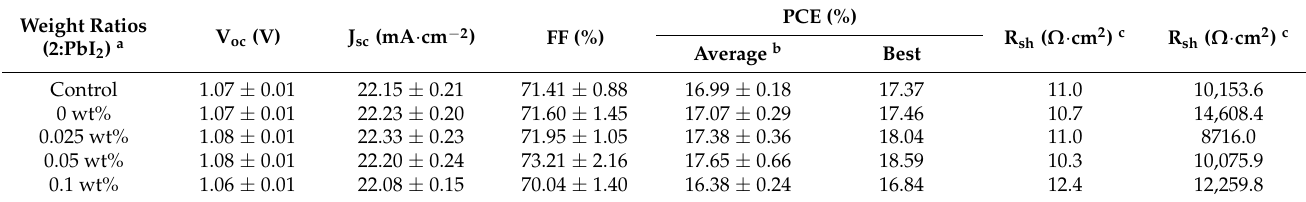
Table 1. Device parameters of perovskite solar cells using 2 as additive of perovskite films under AM 1.5 G simulated sun light with and without 2 measured under illumination of an AM 1.5 solar simulator (100 mW cm − 2 ) in air.